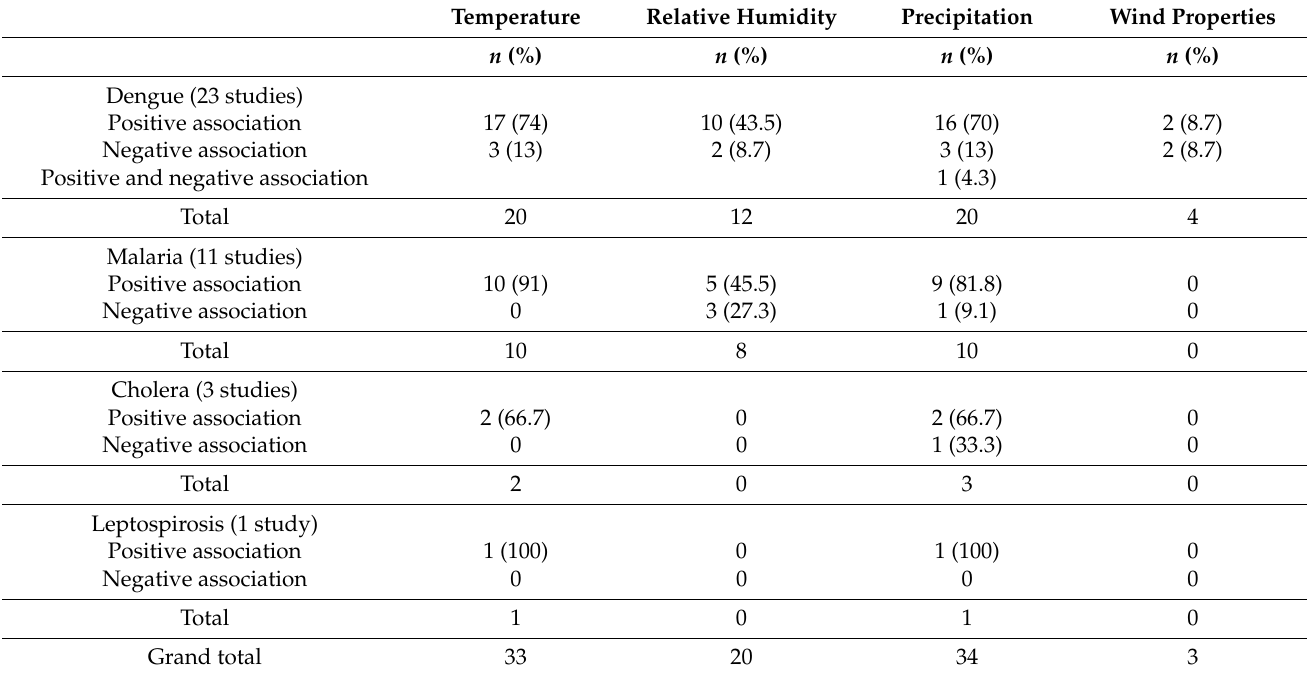
Table 3. Summaries of mereological factors associated with selected climate-sensitive communicable disease.